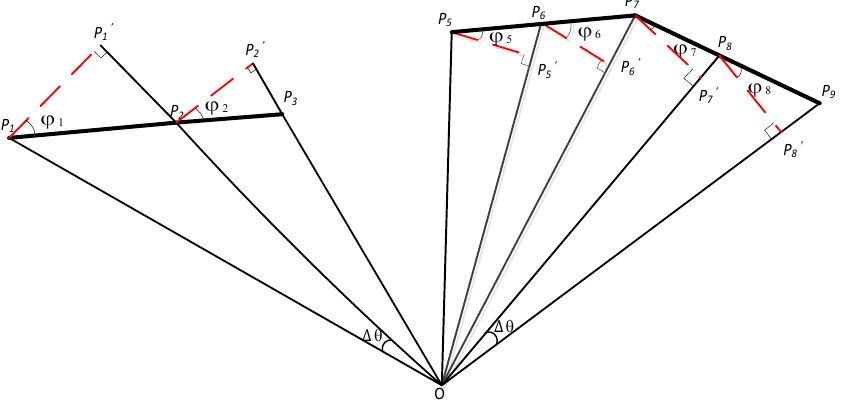
Figure 5. Schematic diagram of the scanning